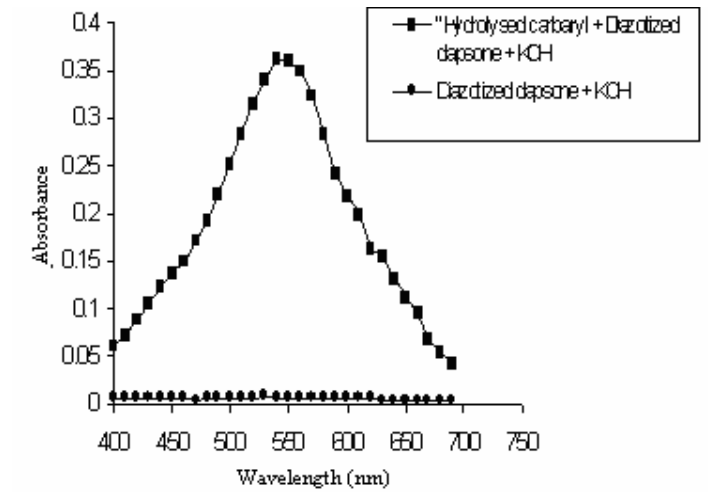
Figure 1 . Absorption spectra of the reaction Product of Hydrolyzed Carbaryl and Reagent